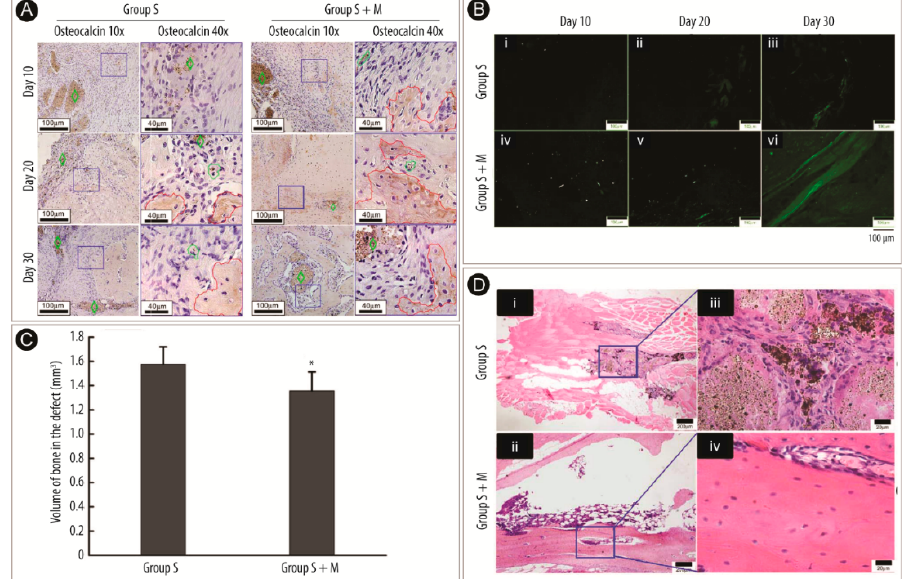
Figure 6. Superparamagnetic responsive scaffolds under a magnetic field enhance osteogenesis for bone repair in vivo. Osteocalcin (OCN) expression induced by the iron-oxide nanoparticle (IO-NP)-containing scaffolds (S) ± magnetic field (M) after 10, 20, and 30 days after implantation ( A ). Red outlined area = positive cells, green rhombus = scaffold. Collagen deposition in the scaffolds ( B ). Stained with Sirius red. Amount of new bone formed in the defects after 110 days, obtained from micro-computed tomography (micro-CT) ( C ); * p < 0.1. Histological observation of the bone defects after 110 days of implantation ( D ): (iii,iv) magnifications of the areas in (i,ii), respectively. In (iii), a small amount of scaffold remains can be seen. In (iv), a homogeneous and well-organized bone formation in the defect is observed. Reprinted with permission from Reference [141]. Copyright 2013, Springer Nature.